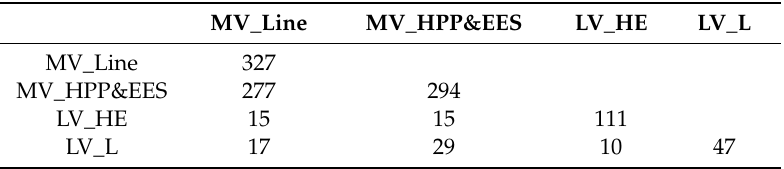
Table 5. Matrix of flagged data in analyzed measurement points.